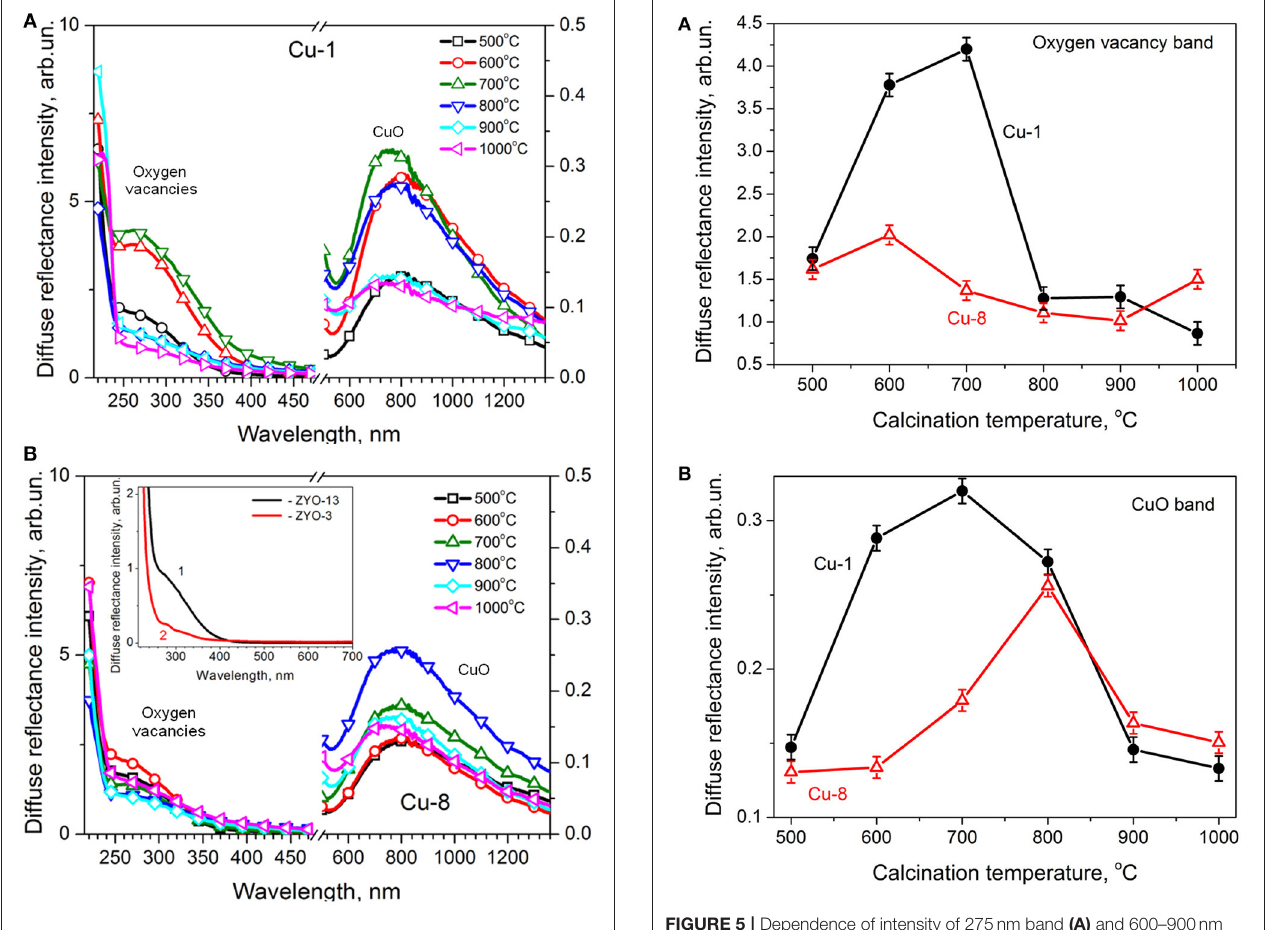
FIGURE 4 | Diffuse reflectance UV-Vis spectra of Cu-1 (A) and Cu-8 (B) samples. Inset in (B) shows the diffuse reflectance spectra for Cu-free YSZ powders with 13 (curve 1) and 3 (curve 2) mol% of Y 2 O 3 prepared from Zr oxychloride.